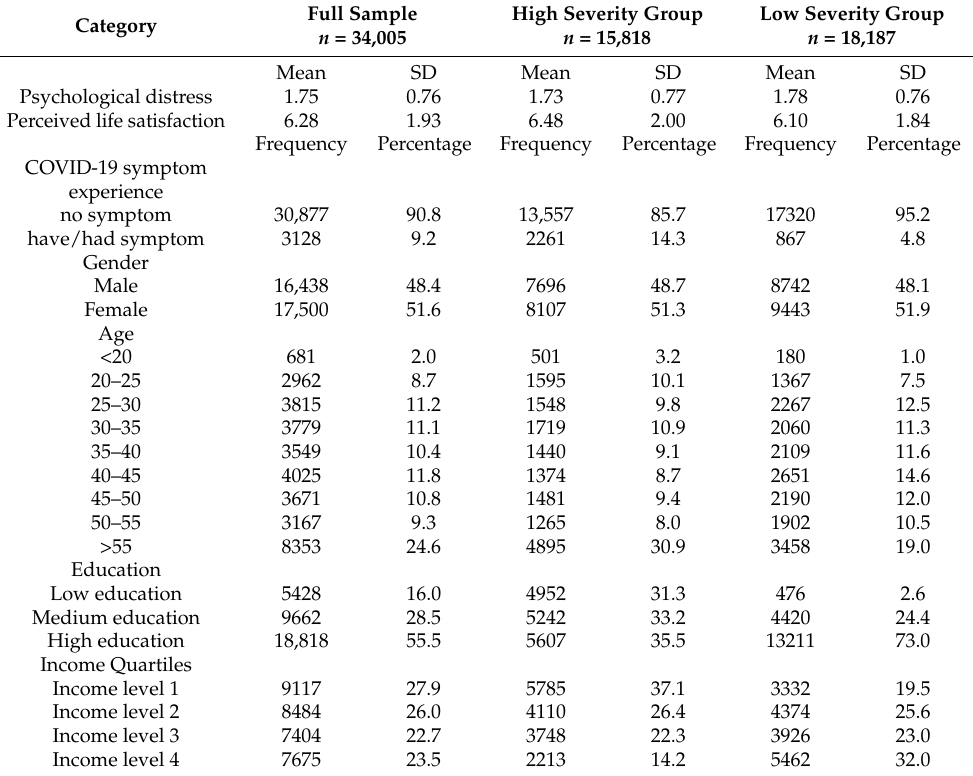
Table A3. Sample